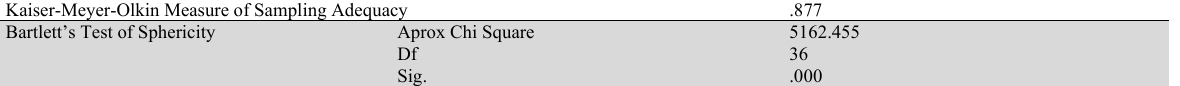
Validity All Items of Workplace Spirituality, Organizational Commitment, and Work Engagement used Confirmatory Factor Analysis (CFA): KMO and Bartlett’s Test Kaiser-Meyer-Olkin Measure of Sampling Adequacy